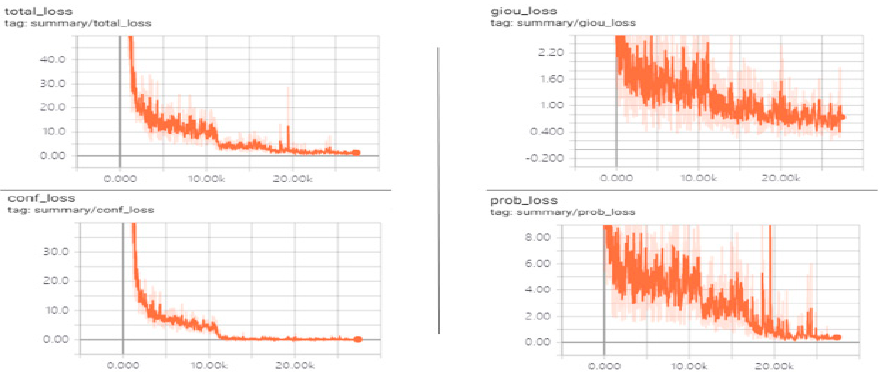
Figure 10. The trends of various loss functions during the training process monitored by TensorBoard.